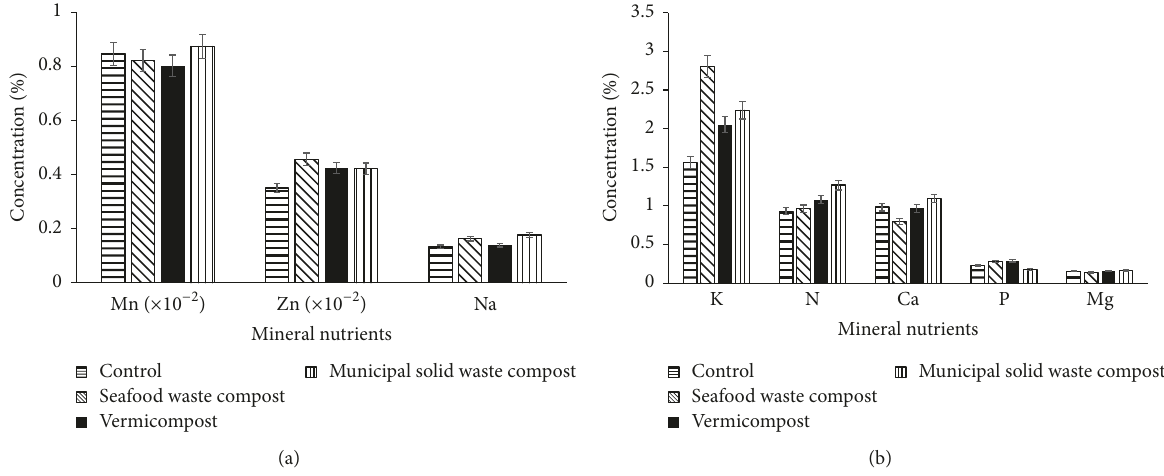
Figure 4: Micronutrients (a) and macronutrients (b) uptake by onion “Sweet Utah” plants grown in peat moss (control), seafood waste compost, vermicompost, and municipal solid waste compost. Manganese (Mn × 10 −2 %); zinc (Zn × 10 −2 %); sodium (Na); potassium (K); calcium (Ca); phosphorus (P); and magnesium